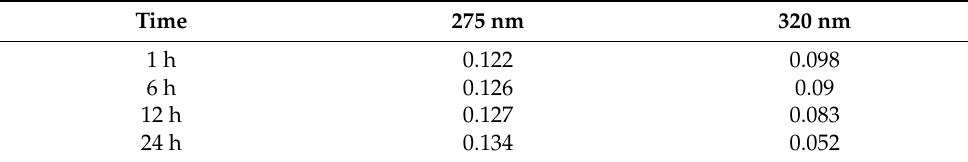
Table 2. Variation in the absorbance of 100 µ M Na 2 WO 4 · 2H 2 O (pH = 3) with reaction time.